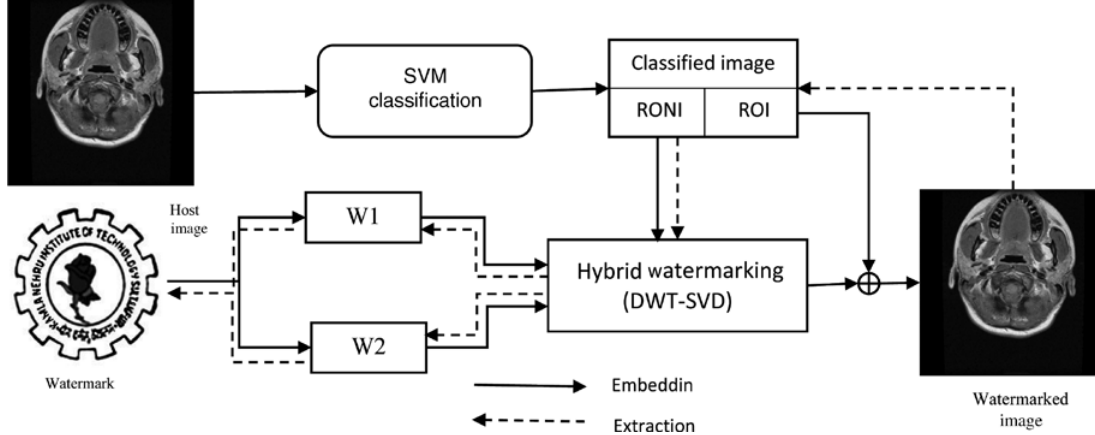
Figure 4: Flow Diagram of the Proposed Watermarking